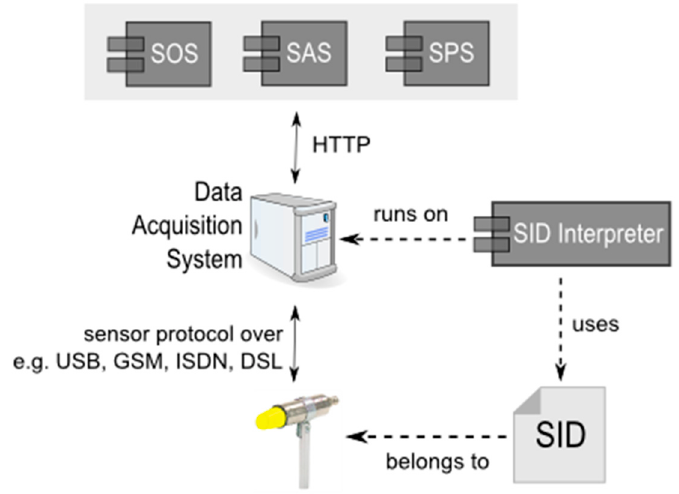
Figure 2. The architecture of SID [20].